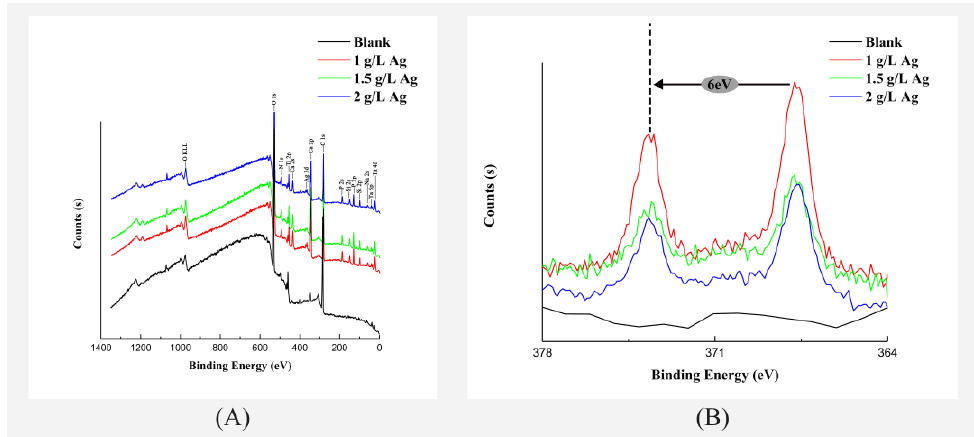
Figure 2. ( A ) XPS survey spectra of the PEO-treated and PEO-untreated samples; ( B ) high-resolution spectra of Ag 3d.